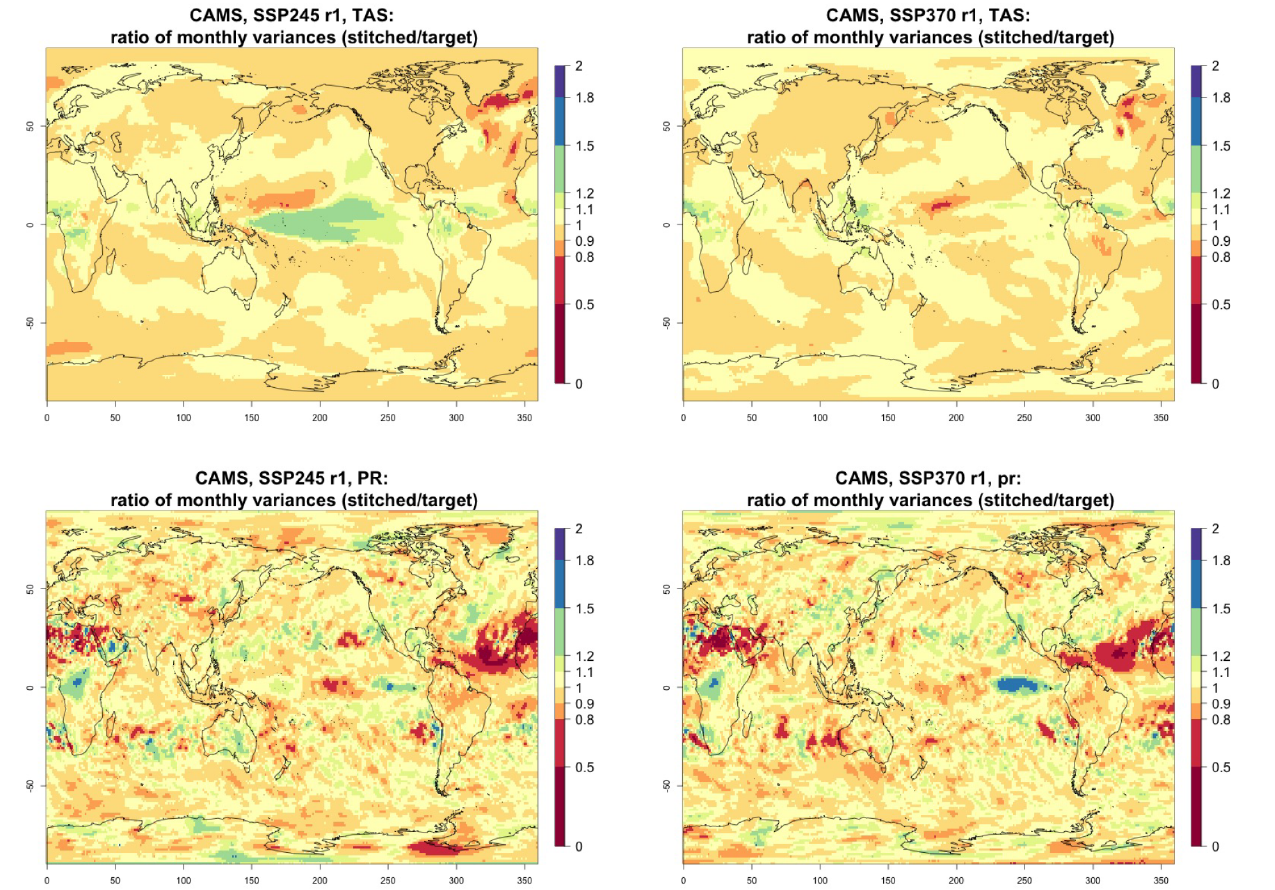
Figure 4. Ratio of monthly variability (standard deviation of residuals from trends) in future temperature (TAS) and precipitation (PR) between stitched (at the numerator) and target (at the denominator) realizations. The value of the ratio is expressed by the color scale, which highlights the transition at 0.8 and 1.2. Emulation of CAMS-CM1-0 monthly time series for 2015–2100 under SSP2-4.5 and